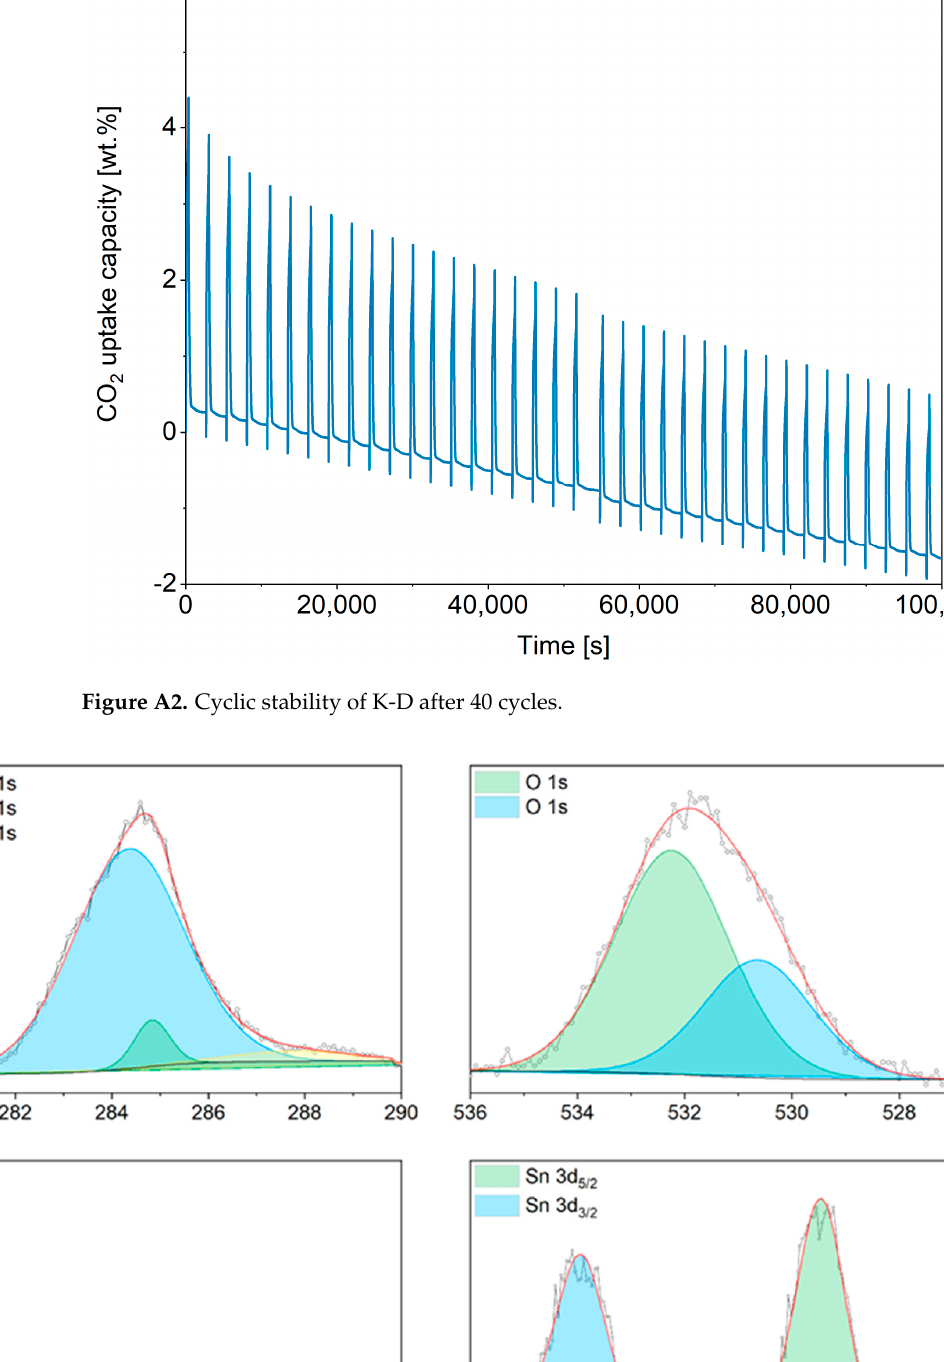
Figure A3. XPS of raw K-A.